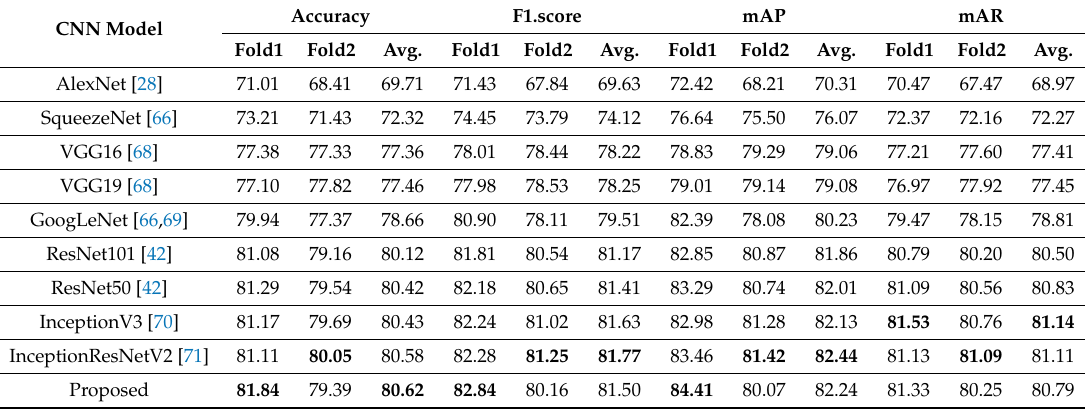
Table 5. Classification performance of proposed and di ff erent baseline CNN models after the training from scratch (unit: %).